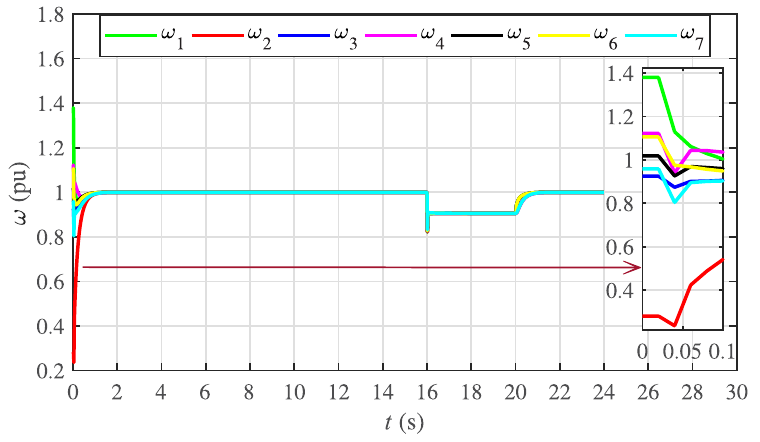
Fig 36. Frequency regulation with leader-follower and leaderless consensus under case 3.